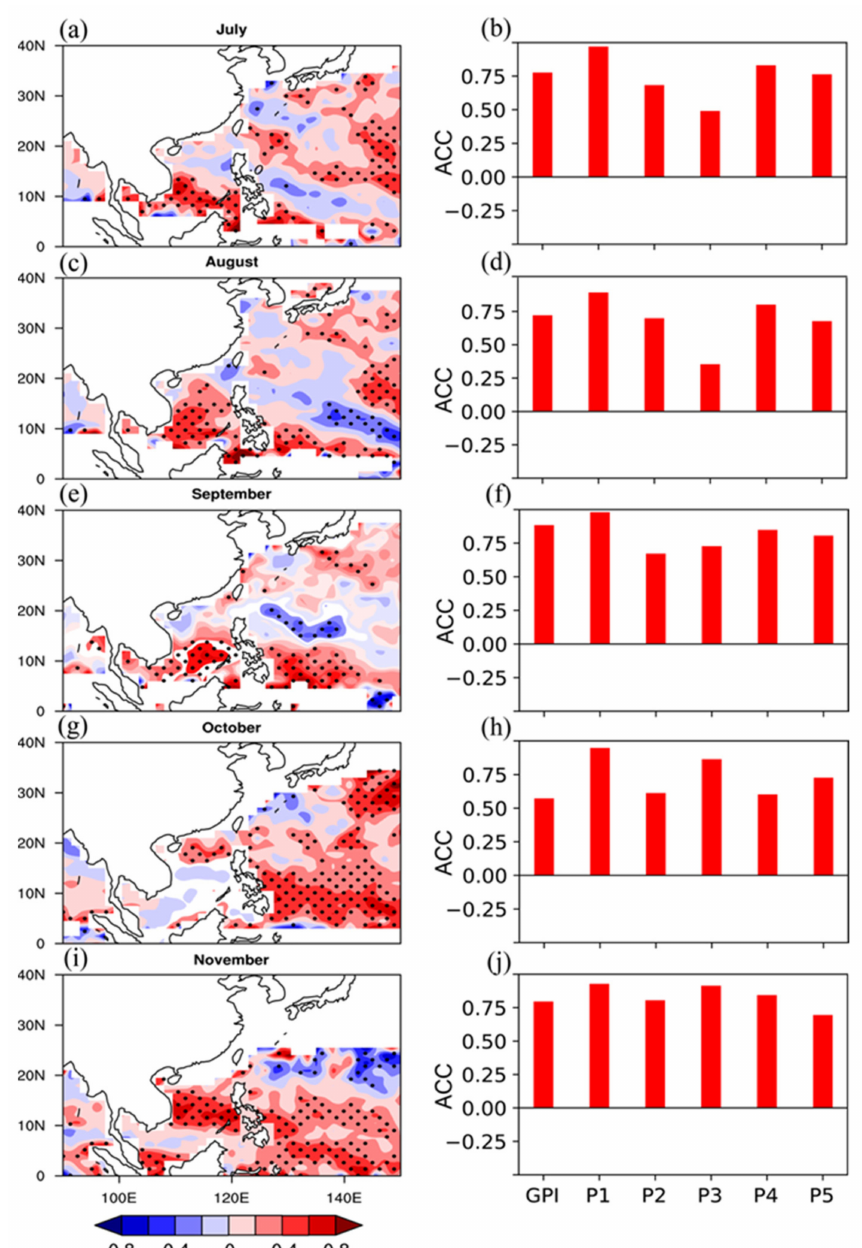
Figure 7. The temporal correlation coefficient (TCC) for the monthly tropical cyclone genesis potential index (GPI) between the observation and FGOALS-f2. The monthly hindcast results from July to November ( a , c , e , g , i ) with 10-day leading are given, respectively, based on the different initial conditions. In addition, the anomaly correlation coefficient (ACC) of the monthly tropical cyclone genesis potential index (GPI) and each part of the equation between ERA-interim and the hindcast of FGOALS-f2 from July to November are also given, respectively ( b , d , f , h , j ). P1 to P4 means parts (cid:12) 3/2 , P2 represents the equation: RH 1 to 4 of Equation (2). P1 represents the equation: , (cid:12) 10 5 vort850 | 50 P3 represents the equation: V m , P4 represents the equation: ( 1 + 0.1V shear ) − 2 , and P5 represents the 70 equation: ω + 0.1 0.1